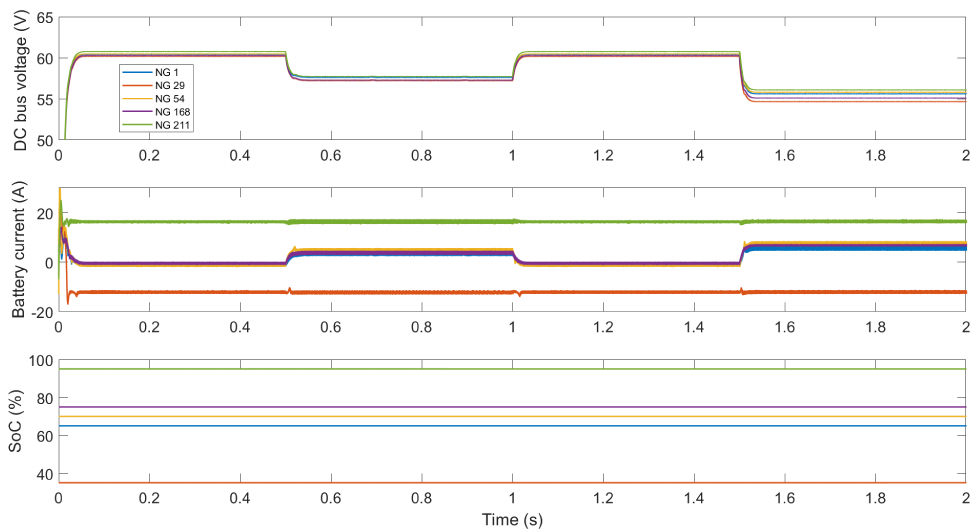
Figure 17. Evolution of the DC bus voltage, the battery currents and the SoCs of the NGs for stability analysis with sudden connection and disconnection of a communal